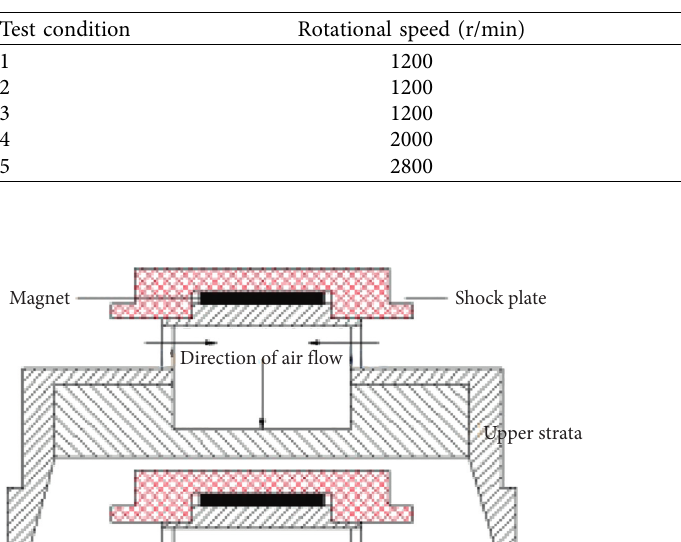
Table 2: The test conditions.